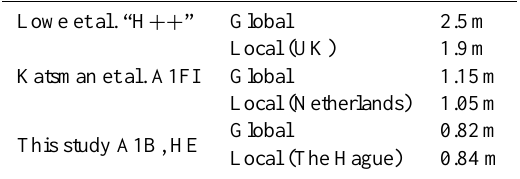
Table 3. High-end 21st century sea-level change figures taken from Lowe et al. (2009), Katsman et al. (2011) and this study. The Lowe et al. figures are the top of the range of their “H ++ ” scenario, with “Local” referring to the coast of the UK. The Katsman figures are the top of the range of their high-end scenario, with “Local” re- ferring to the coast of the Netherlands. For this study the “Local” figure refers to The Hague. Figures for Lowe et al. (2009) and for this study exclude both GIA and SRG because these were not treated in the same way in all three studies. Lowe et al. “H ++ ” Global 2.5m Local (UK) 1.9m Katsman et al. A1FI Global 1.15m Local (Netherlands) 1.05m Global 0.82m This study A1B, HE Local (The Hague) 0.84 m